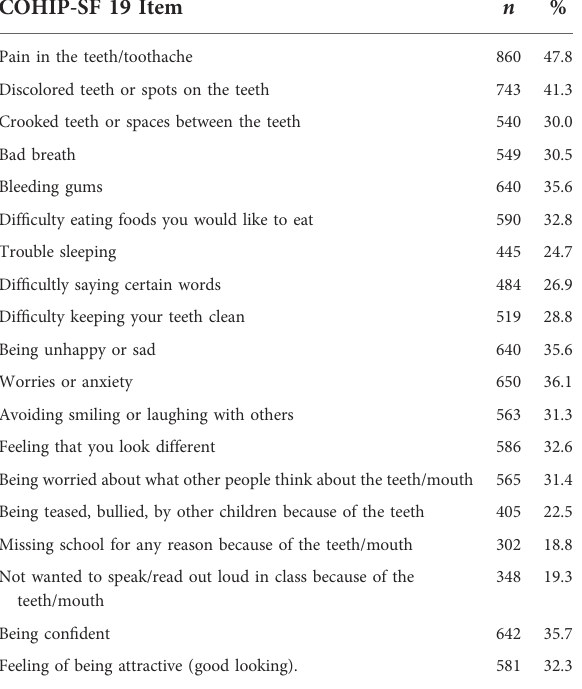
TABLE 3 COHIP-SF 19 OHRQoL items impacted upon by oral health. TABLE 4 Bivariate analysis of impact of oral hygiene habits on